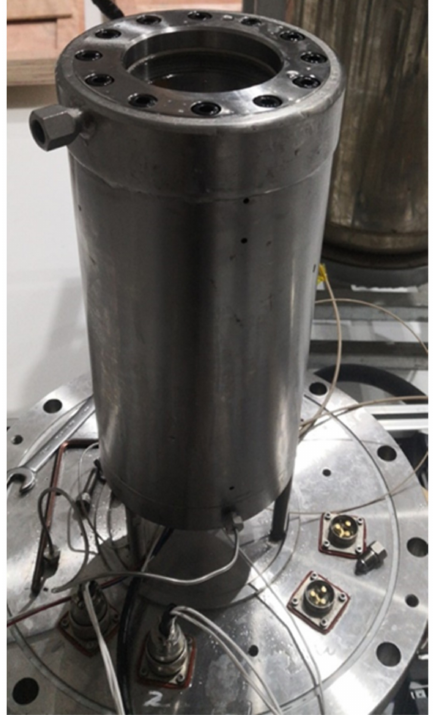
Figure 5. Reaction kettle real